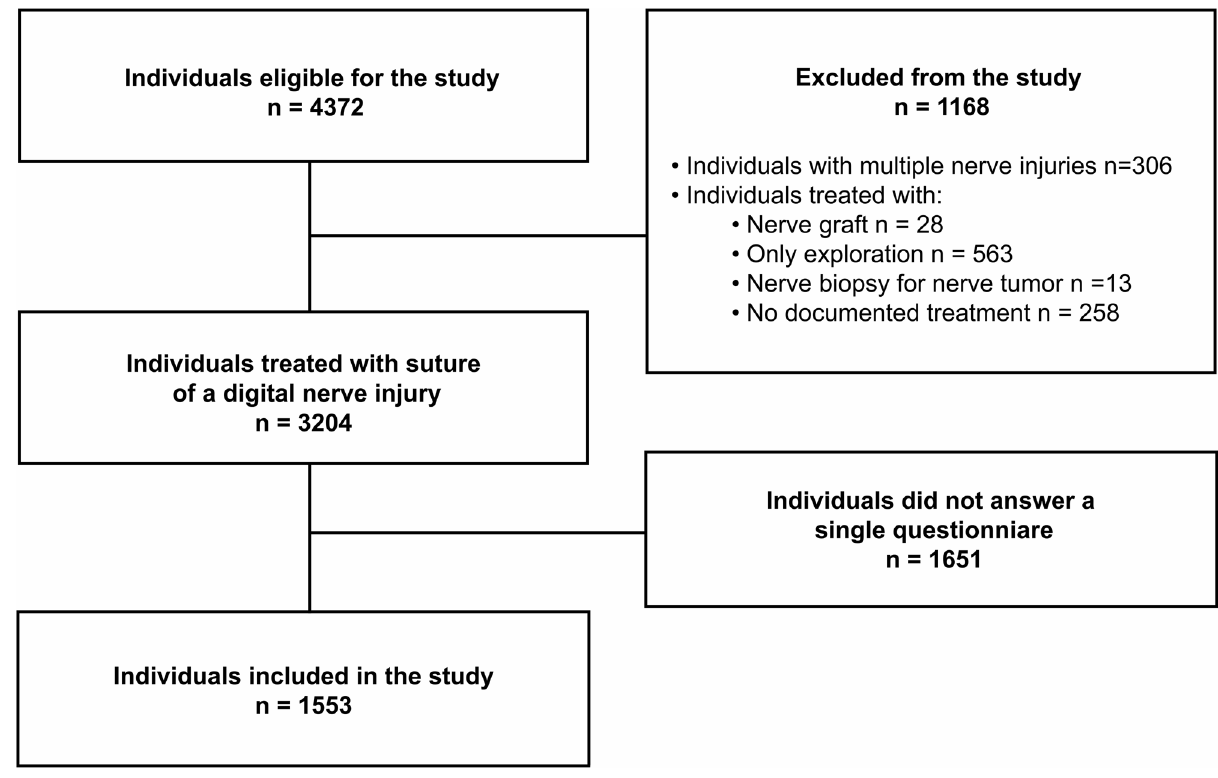
Figure 1. Study patient flow